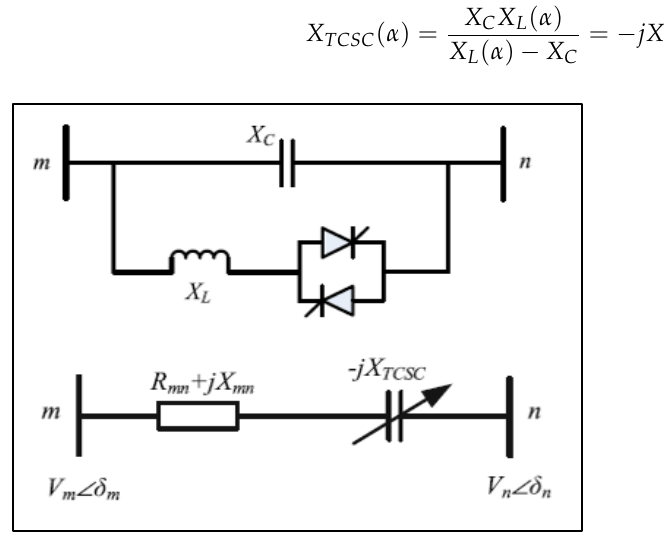
Figure 4. Basic Structure and model of TCSC [23].